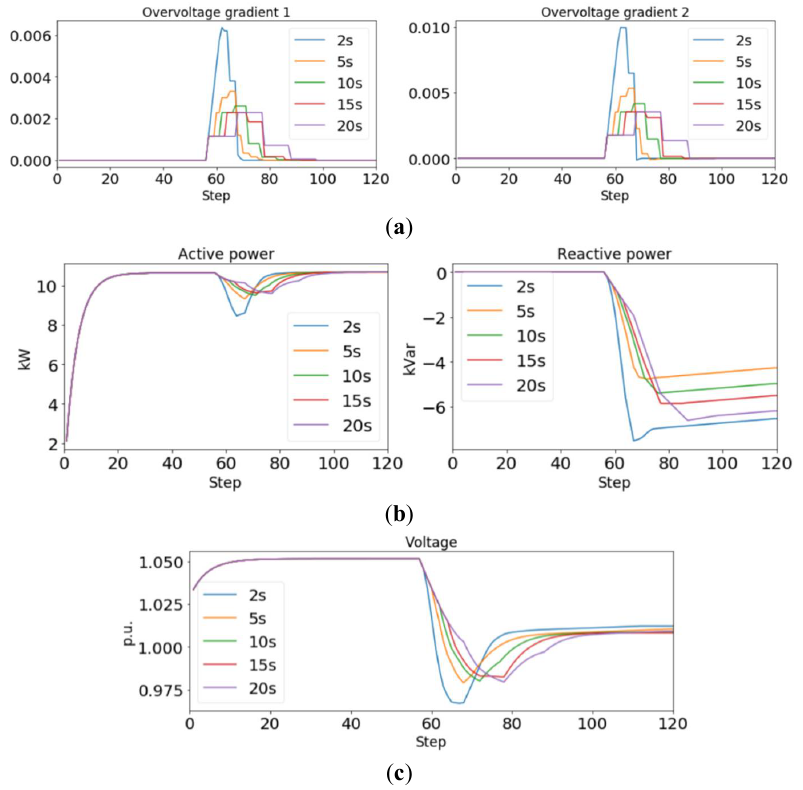
Figure 10. Impact on voltage regulation with different time steps in the coordinator: ( a ) outputs of the coordinator; ( b ) active and reactive power output of a selected PV inverter, and ( c ) voltage meas- urements.